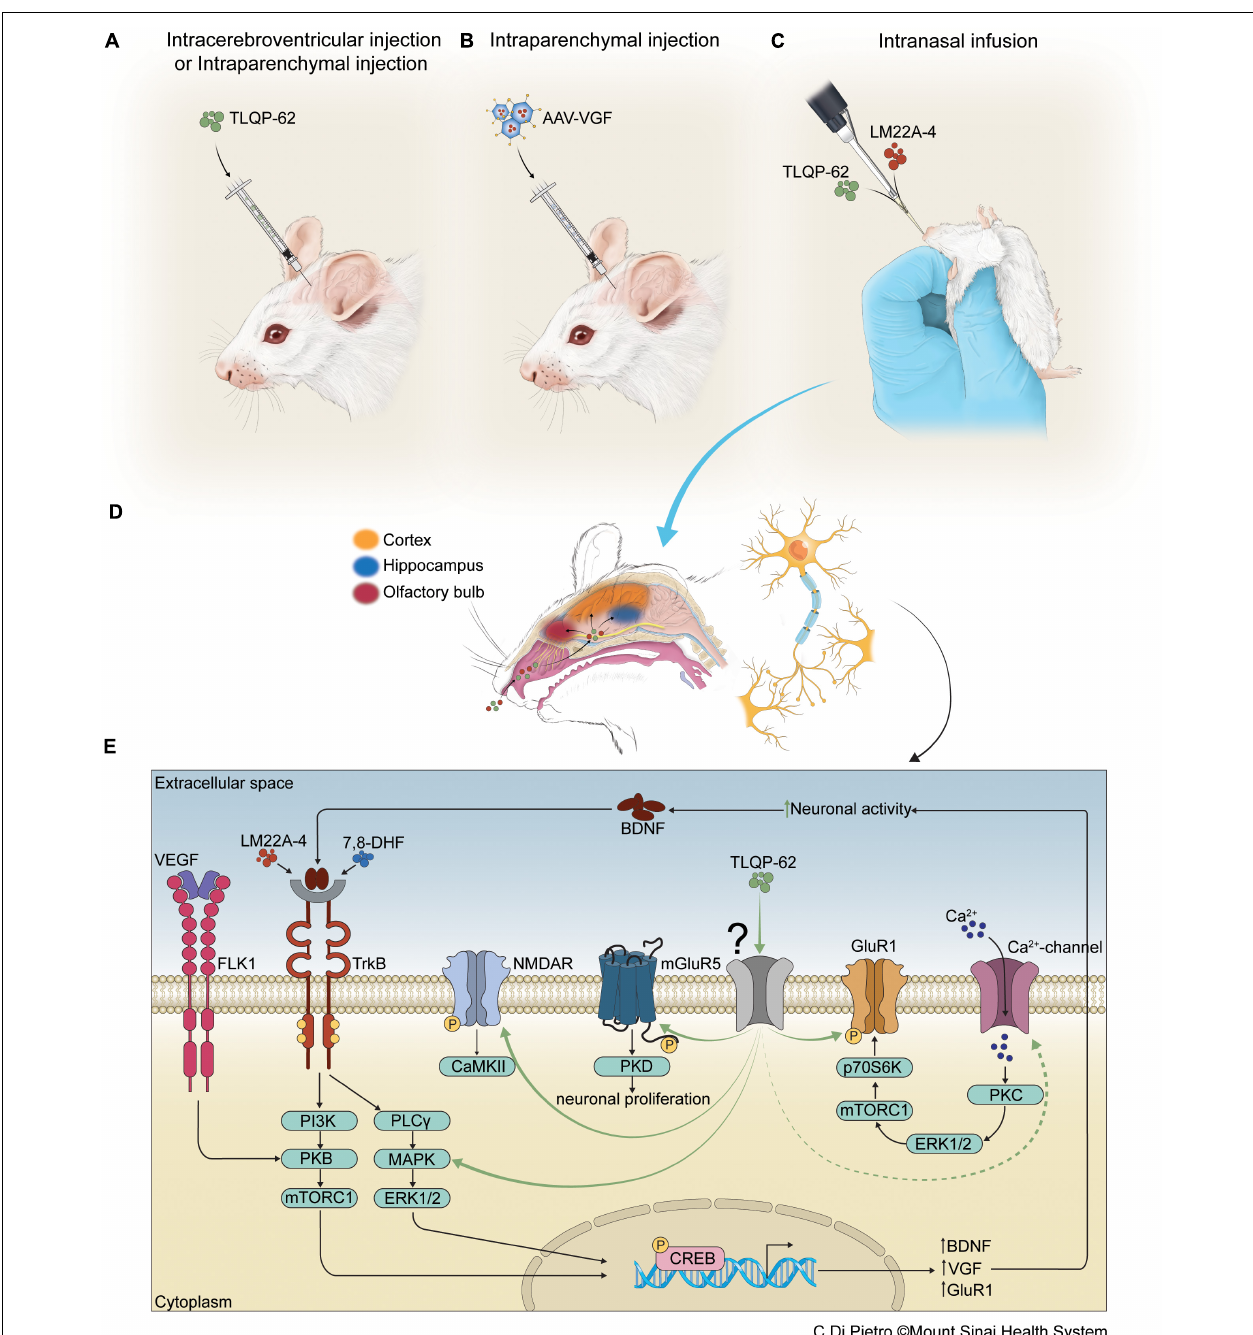
FIGURE 1 | Antidepressant efficacy of therapeutics, delivered to CNS via intracortical, intrahippocampal, intracerebroventricular, and intranasal routes, that target neurotrophin signaling pathways. Panels (A,B) depict intracerebroventricular (icv), intracortical, or intrahippocampal infusions of neuropeptide TLQP-62 or AAV-VGF into rodent brain, while panel (C) depicts intranasal administration of small molecule agonists, including the TrkB agonist LM22A-4, and neuropeptides, such as TLQP-62, for delivery of pharmacotherapeutics to the CNS. Proposed diffusion pathways of agents delivered intranasally, bypassing the blood-brain-barrier (BBB), for distal delivery via the CSF and the perivascular spaces around cranial nerves, to the various brain regions shown in panel (D) . In panel (E) , the antidepressant-like actions of TLQP-62 are shown to be mediated through an unknown receptor (in gray), leading to activation of known glutamatergic signaling pathways, including NMDAR and mGluR5 (Thakker-Varia et al., 2014), the BDNF/TrkB signaling cascade (Jiang et al., 2019a), and calcium channels which activate GluR1 (Jiang et al., 2019a). Other BDNF mimetic/agonists, including LM22A-4 (Fletcher et al., 2021) and 7,8-DHF (Wurzelmann et al., 2017), have shown antidepressant efficacy via TrkB activation. Additionally, vascular endothelial growth factor (VEGF) is shown to induce antidepressant effects via PI3K/PKB/mTORC1 pathways that activate CREB. Activated CREB increases BDNF and VGF transcription, leading to increased BDNF and VGF translation and secretion, and stimulation of BDNF/TrkB signaling – an autoregulatory